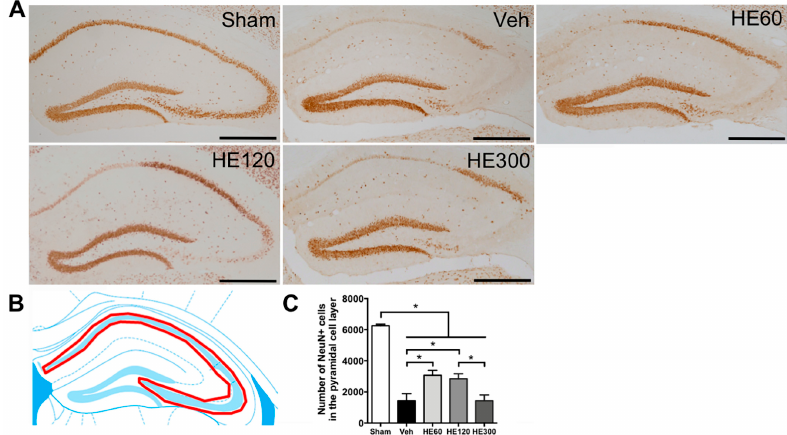
Figure 2. HE treatment at 60 mg/kg resulted in significant hippocampal neuroprotection after pilocarpine-induced status epilepticus. ( A ) Representative photomicrographs showing immunohistochemistry to neuronal nuclei (NeuN) in sham, vehicle (Veh)-, 60 mg/kg of HE- (HE60), 120 mg/kg of HE- (HE120), and 300 mg/kg of HE-treated groups (HE300). Scale bar: 500 μ m. ( B ) A drawing of the hippocampus indicating the region for the quantitative analysis of neuronal survival (shown in red). ( C ) A graph showing the number of NeuN-expressing cells in the pyramidal cell layer. Note that Veh-treated group showed a marked reduction in the number of NeuN-positive neurons compared to sham at 7 d after status epilepticus (SE). However, 60 mg/kg and 120 mg/kg of HE administration significantly prevented neuronal death against SE, whereas 300 mg/kg of HE showed the similar number of surviving pyramidal neurons compared to Veh-treated animals. Data are shown as mean ± SEM. n = 6 (sham), n = 9 (Veh), n = 6 (HE60), n = 9 (HE120), n = 6 (HE300). * p < 0.05; one-way ANOVA with Tukey’s post-hoc test.